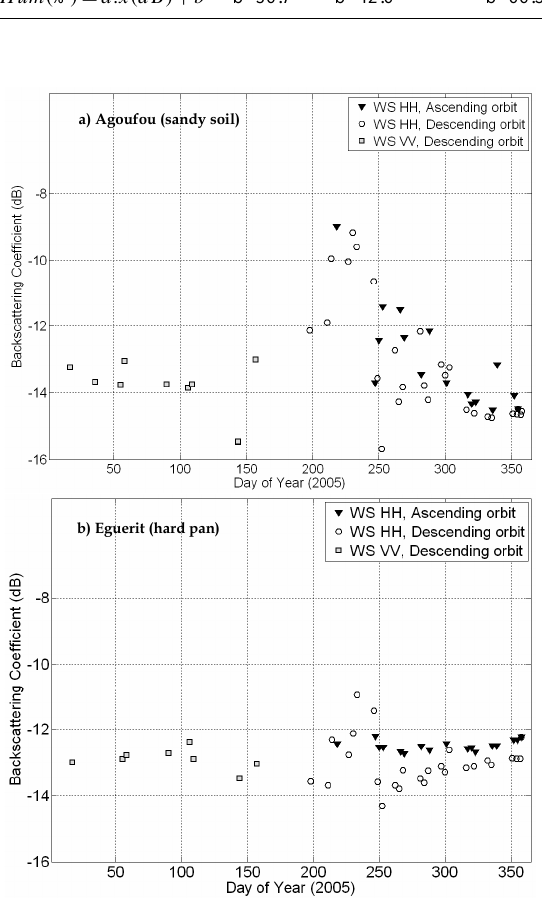
660 Fig. 6: Temporal variation of the normalized (23°) backscattering coefficient in 2005 for the 661 Agoufou sandy (a) and the Eguerit rocky (b) sites.